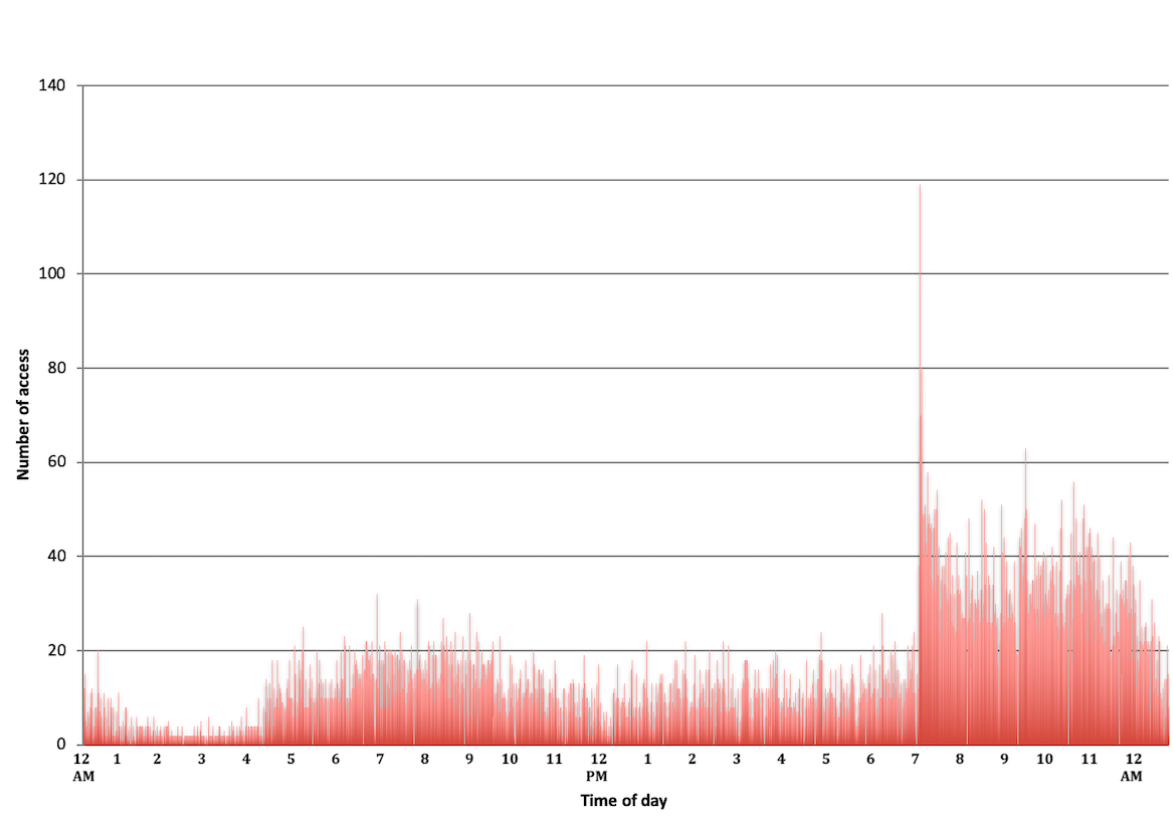
Figure 5. App use tracked by number of logins by time of day exploring the effectiveness of reminders. Note that automatic app reminders are default to send around 7:00 pm.